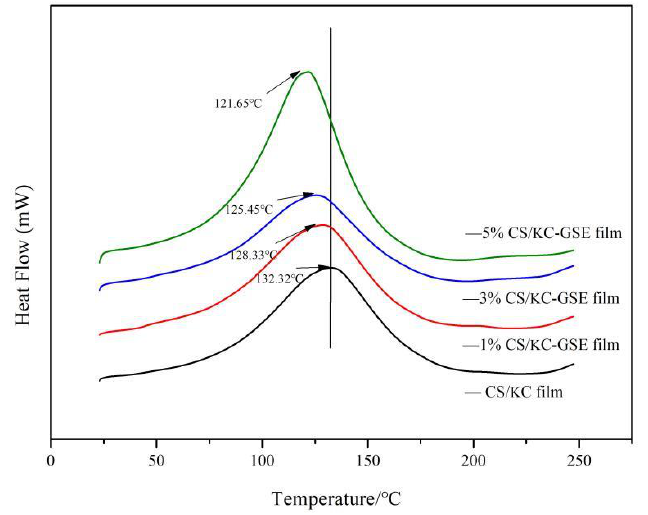
Figure 4. DSC curves of CS/ κ C, 1% CS/ κ C-GSE, 3% CS/ κ C-GSE, and 5% CS/ κ C-GSE films.